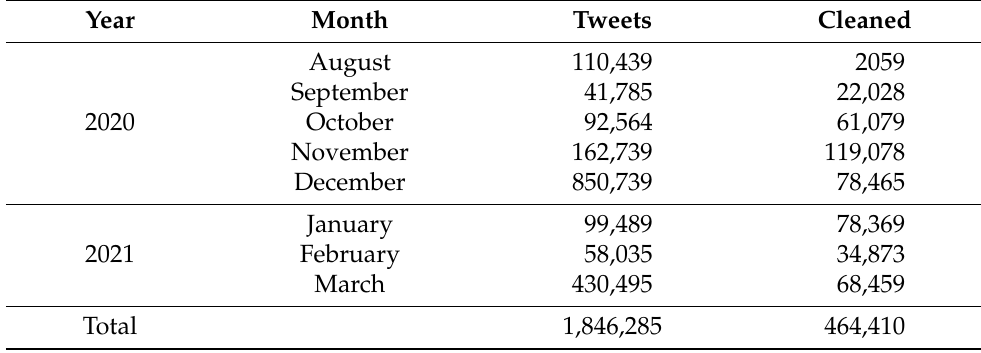
Table 3. The list of hashtags used to collect tweets in our